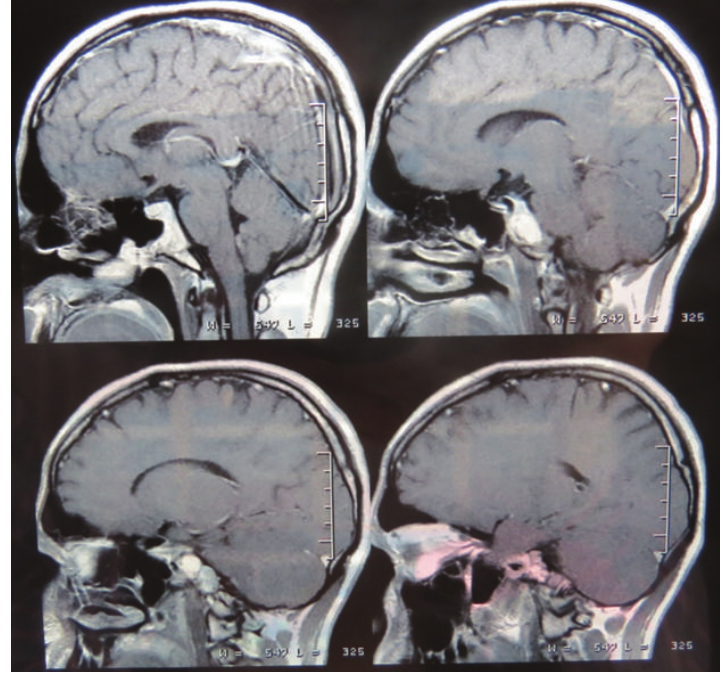
Figure 2: T1 weighted magnetic resonance imaging scans show resolution of the